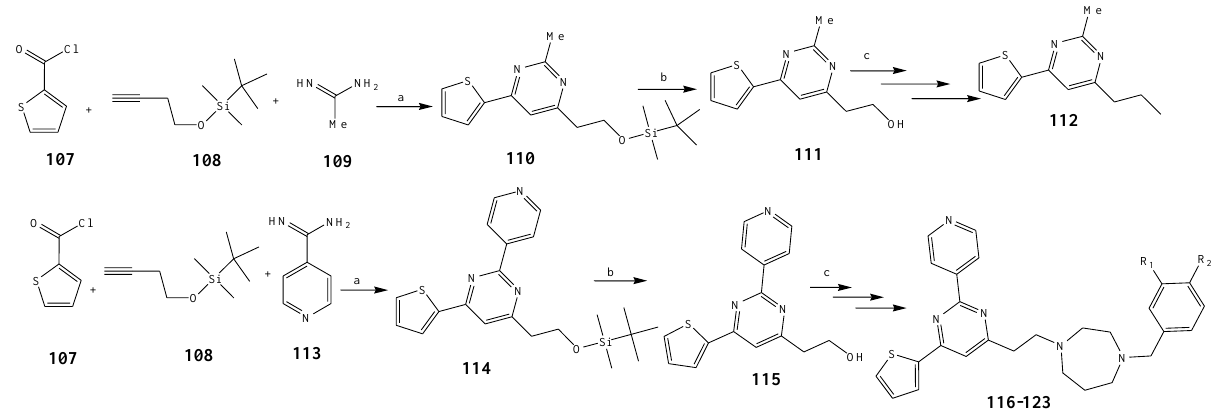
a = (i) 2 mol% Pd(PPh 3 ) 2 Cl 2 /4 mol% CuI/NEt 3 /tetrahydrofuran (THF)/rt 1 – 2 h and (ii) Na 2 CO 3 , reflux